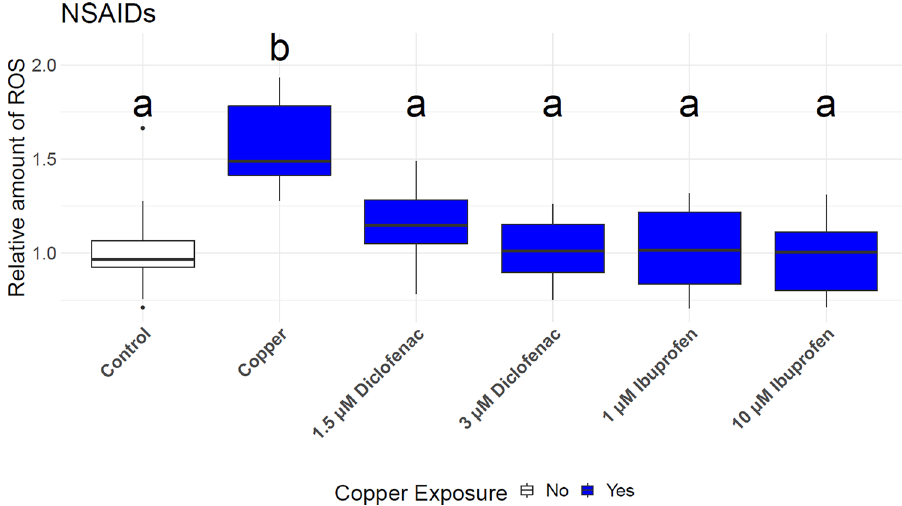
Figure 3. Relative amount of reactive oxygen species (ROS) in larvae treated with diclofenac or ibuprofen before exposed to copper. Fluorescence was measured after 4 h of incubation with the fluorescence dye. Different letters represent significant differences. ANOVA-HSD, n = 24, df = 5, p < 0.05.